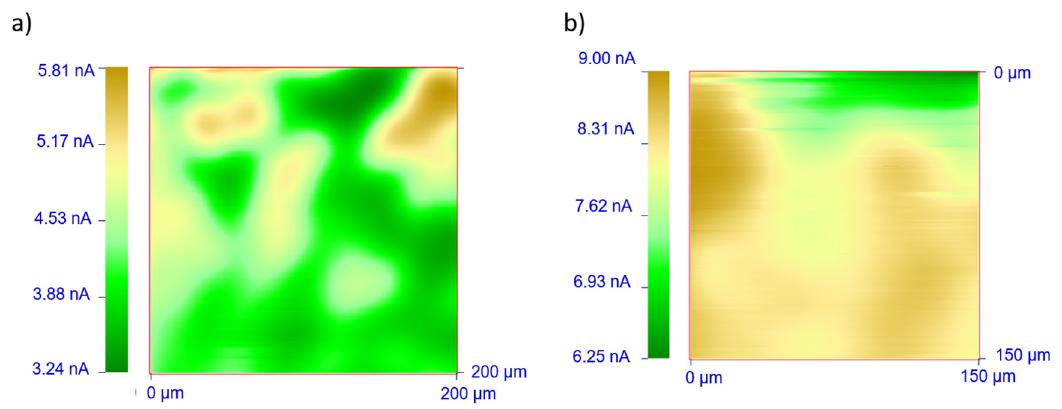
Figure 9. Bi-dimensional scans recorded in a 2 mM K 3 Fe(CN) 6 + 0.1 M KCl water solution with the microelectrode tip located at 10 µm above the oligo-( S )-BT 2 T 4 -Au. Microelectrode tip biased at 0.0 V substrate unbiased ( a ) and biased at 1 V ( b ).